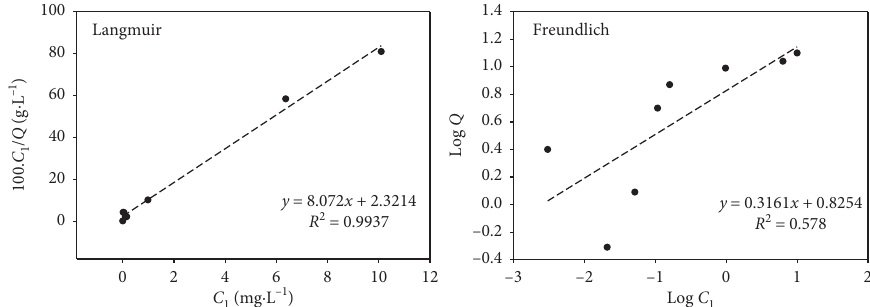
Figure 9: Langmuir and Freundlich adsorption isotherms reflecting Cd 2+ adsorption by the FAMBT